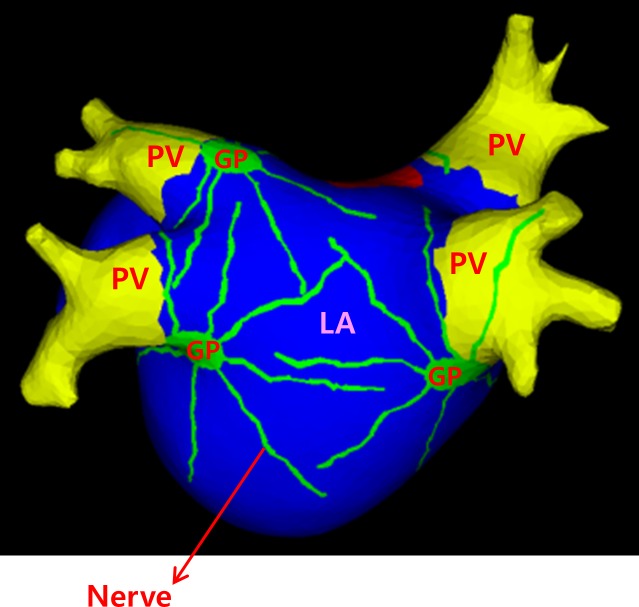
Model of GP and nerves based on the “octopus hypothesis” [6].The PVs and LA area are indicated in yellow and blue, respectively. The GP and nerves are indicated in green.